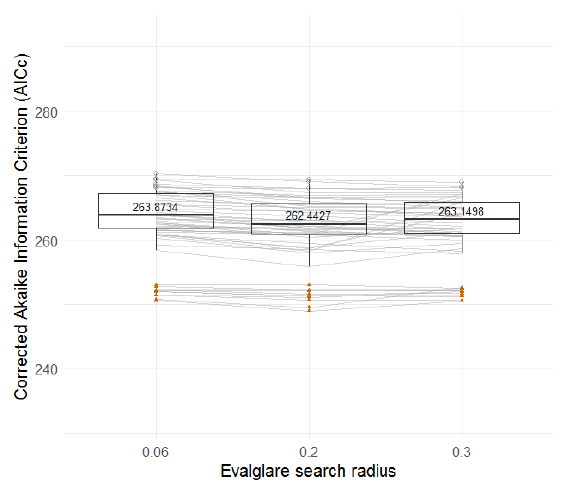
Figure 21. Boxplots of AUC for the three search radius (laboratory study).